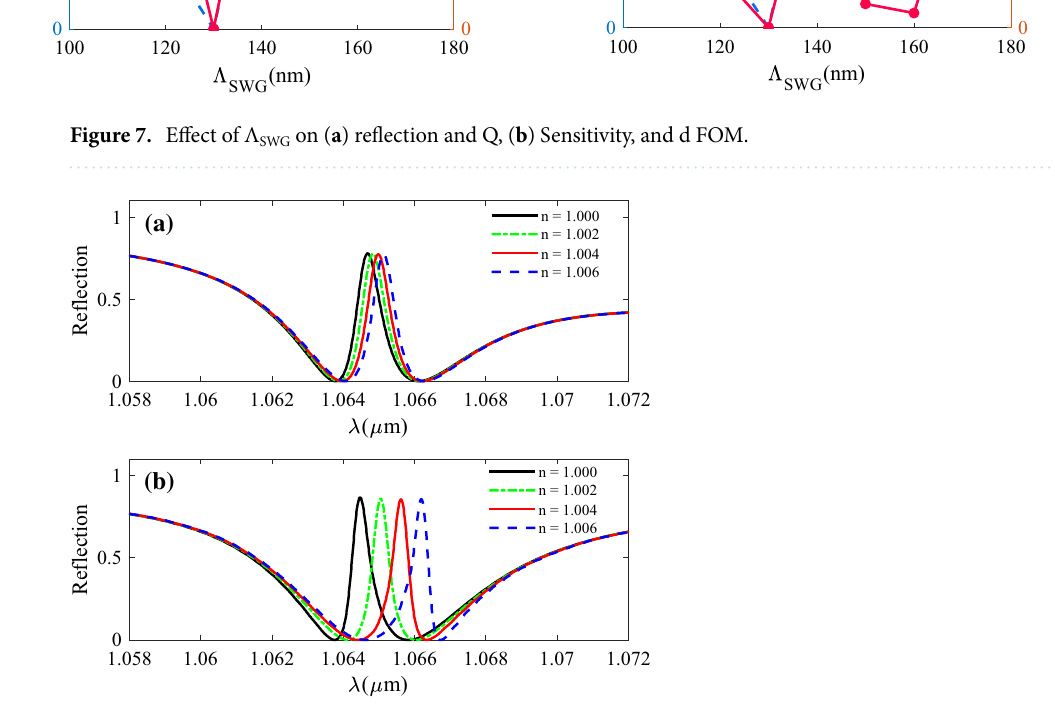
Figure 8. Reflection spectra of the plasmonic system for refractive index change with the step of 0.005 when ( a ) a homogenous silicon layer is used (h Si = 110 nm). ( b ) Silicon SWG is